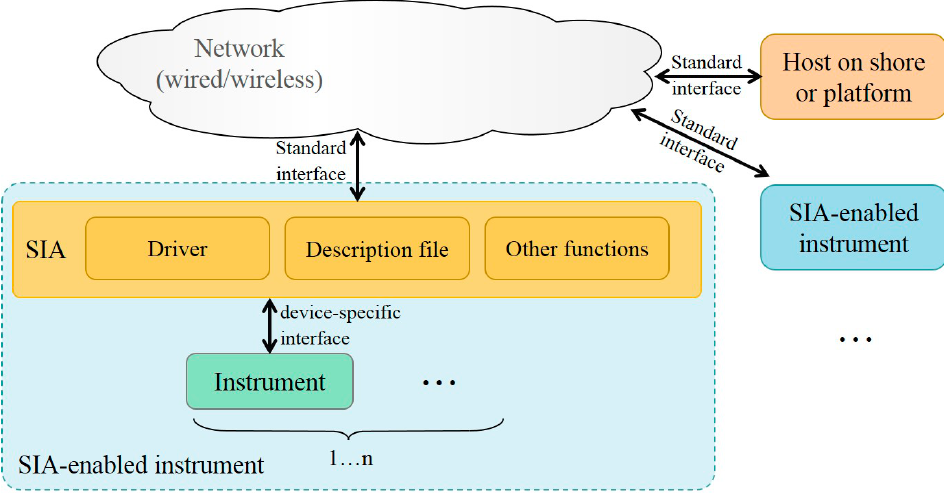
Figure 4. The diagram of SIA-enable instruments [22] .